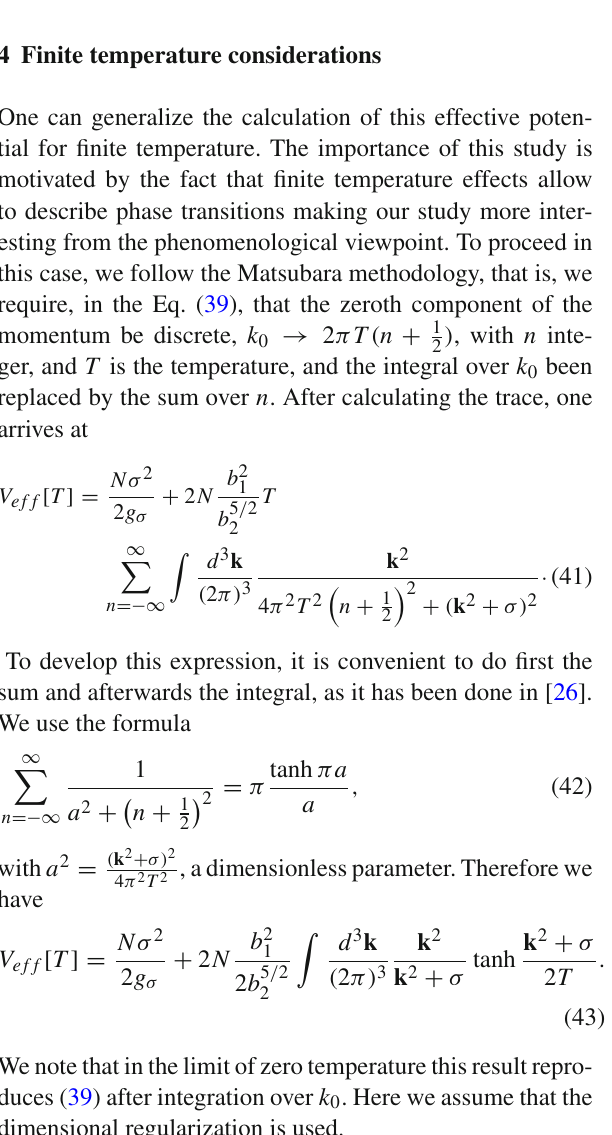
Fig. 2 General aspect of the effective potential for the one-loop effec- tive potential in Gross–Neveu model with z =